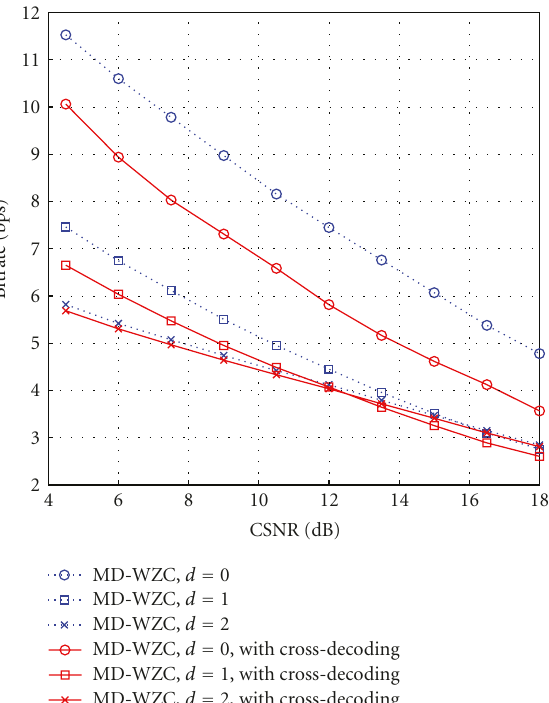
Figure 10: Central rate comparison of the MD-WZC schemes with and without turbo cross-decoding for di ff erent values of d